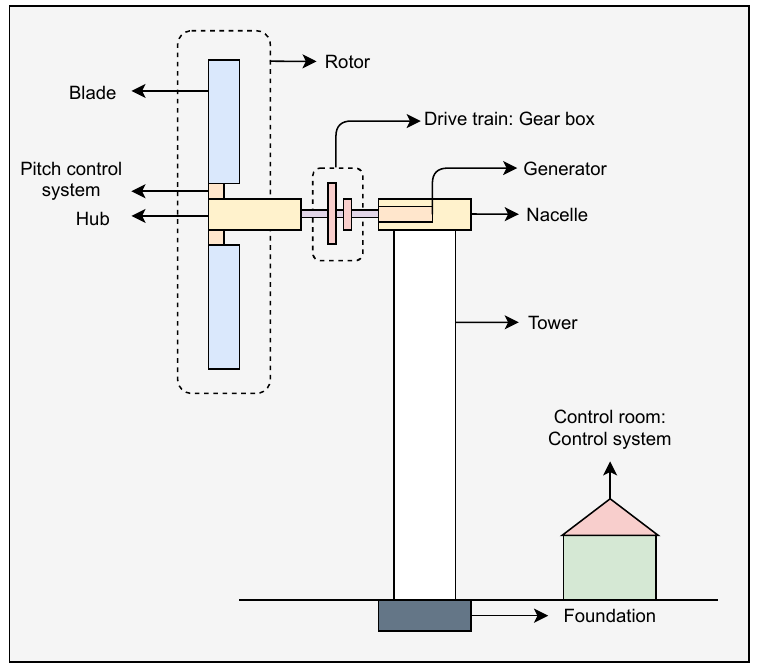
Figure 8. Basic structure and major components of the horizontal axis WT (HAWT) [43]. The blade profile and the airfoil geometry are important parameters of small